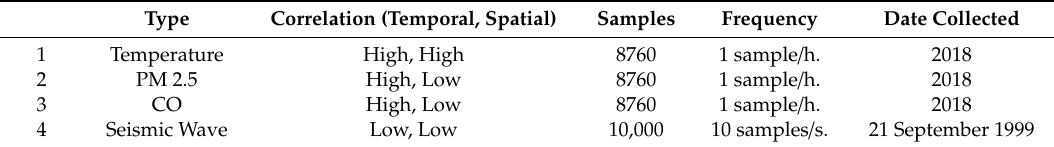
Table 1. Four environmental datasets for testing